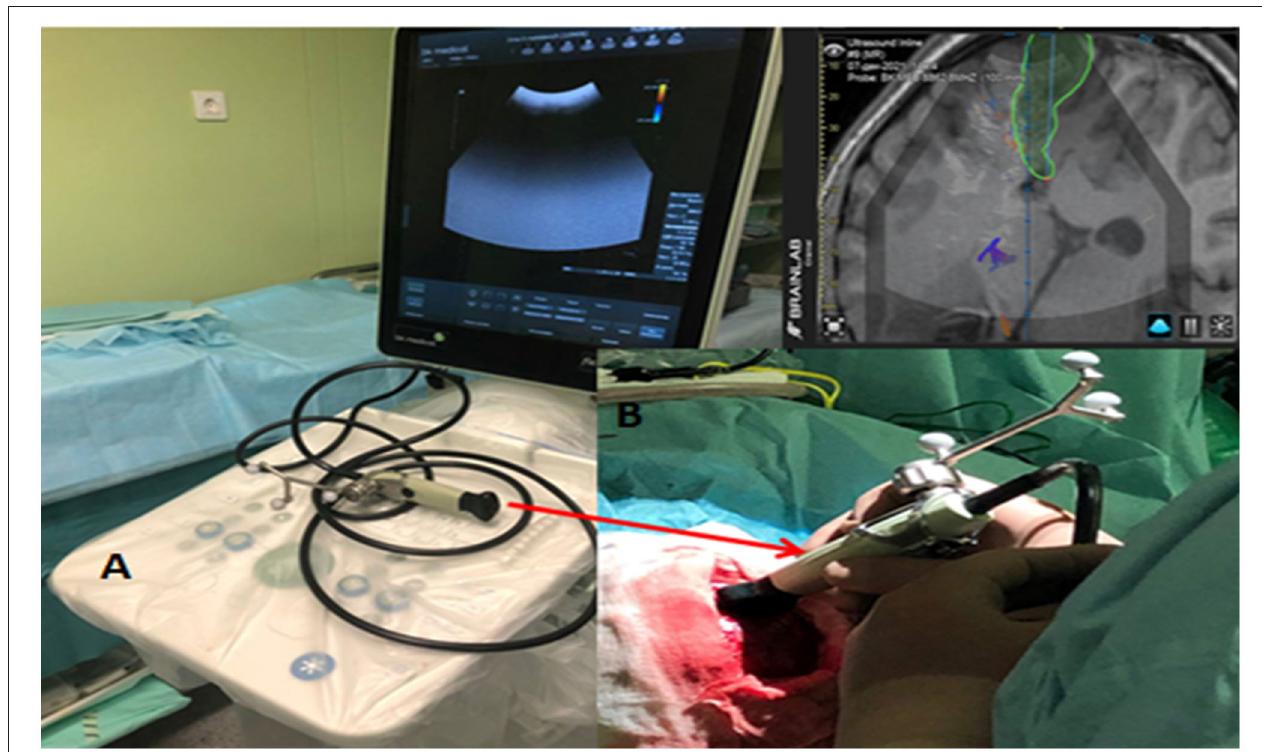
FIGURE 1 | (A) iUS Apparatus - BK Medical flex focus 800 (Denmark) with Sterile convex transducer. (B) Integrated Brain lab neuronavigation system (Germany).